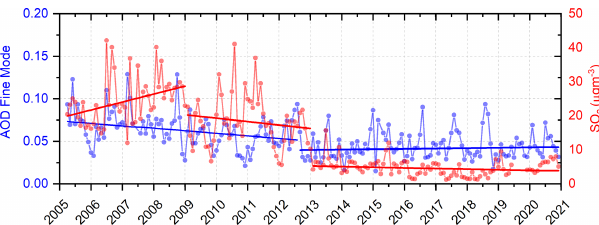
Figure 10. Series of monthly mean values of fine-mode AOD (SCO, in blue) and SO 2 (Tomé Cano station, in red) for the study period